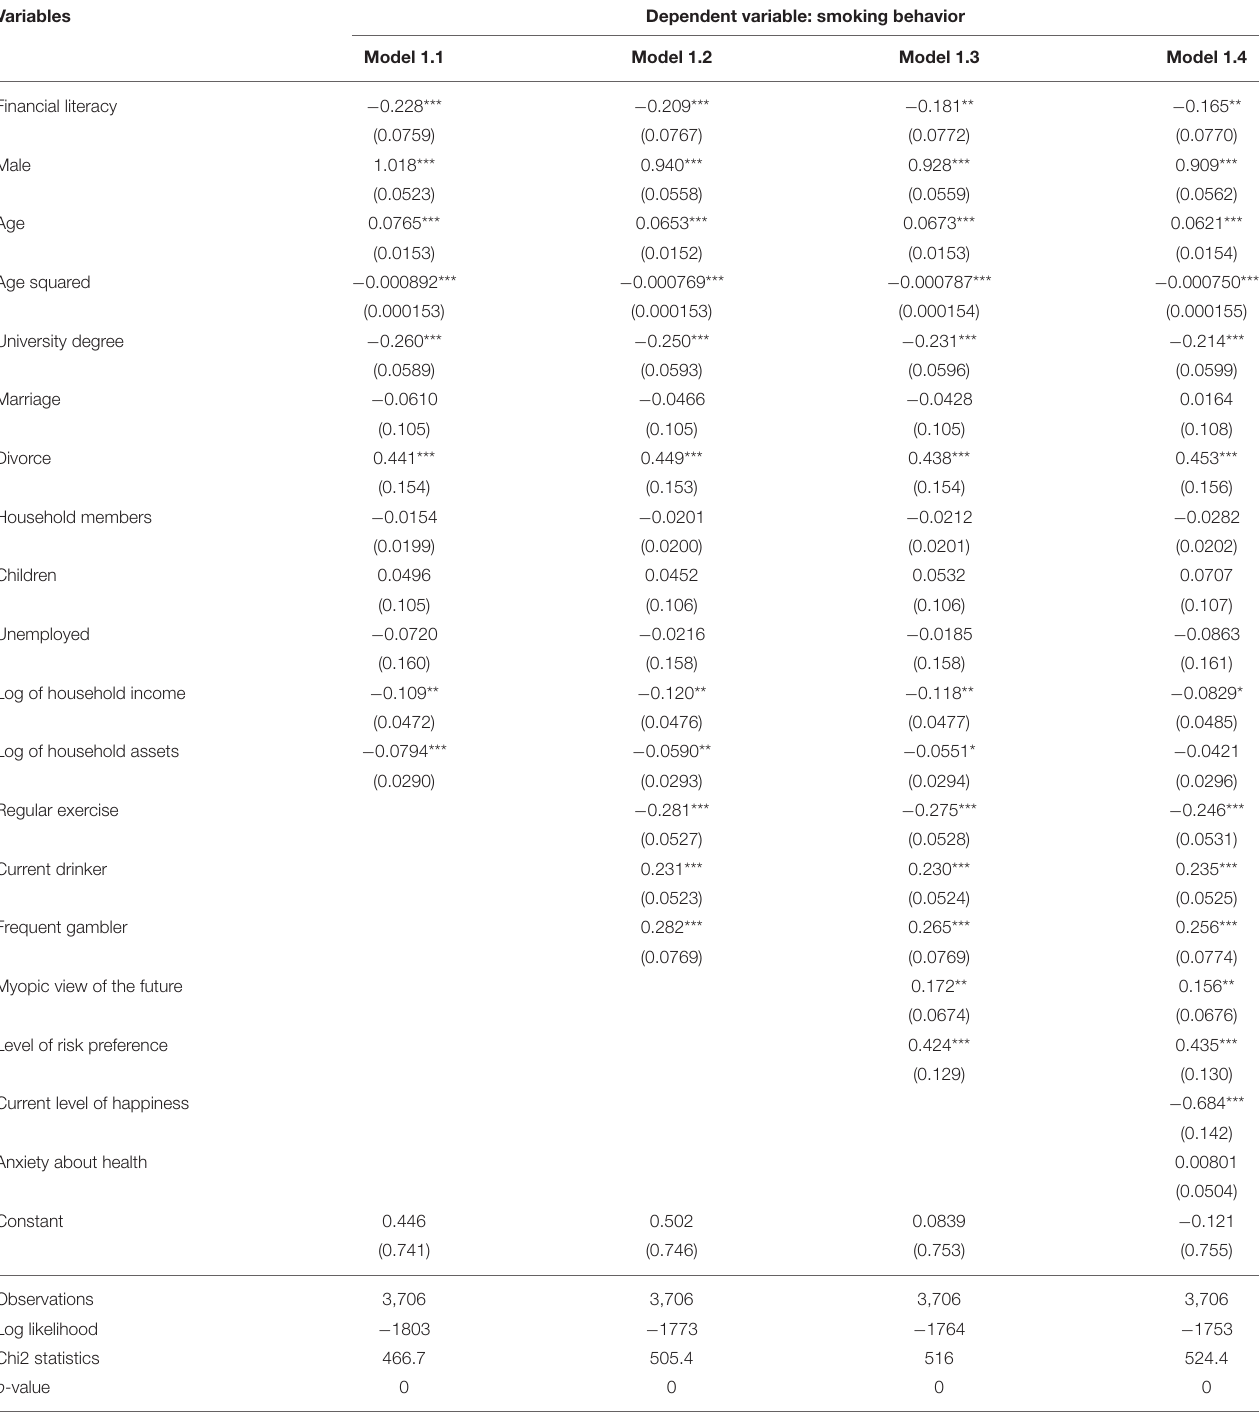
TABLE 6 | Probit model regression results, financial literacy as the main explanatory